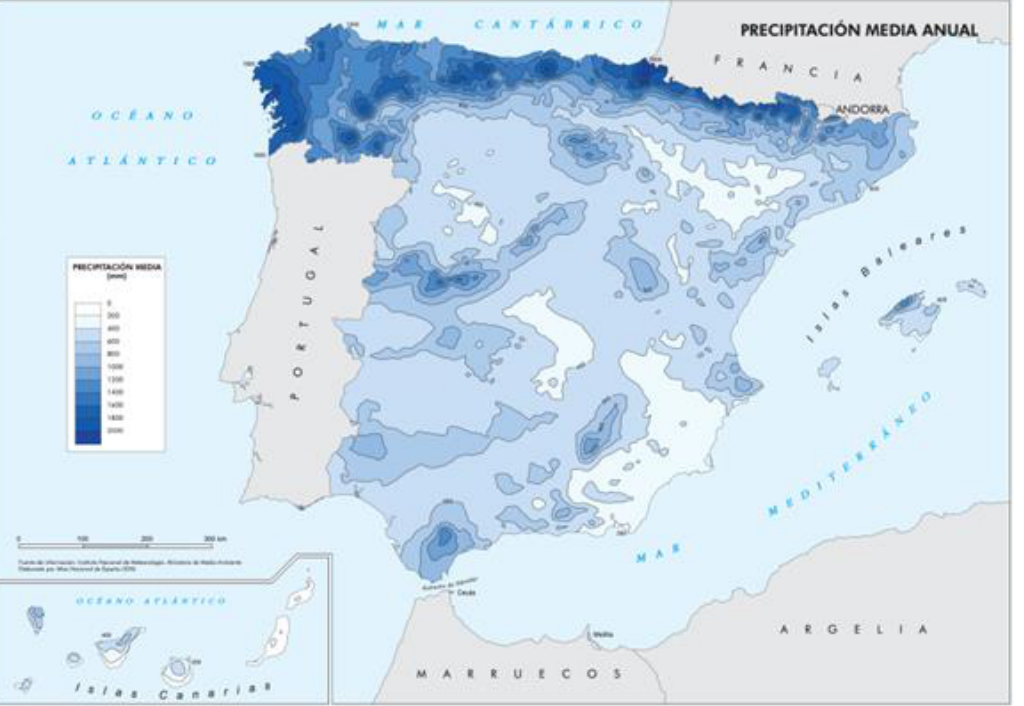
Figure 5. Annual average rainfall in Spain (1980 – 2010). Source: The National Geographic Institute [52].